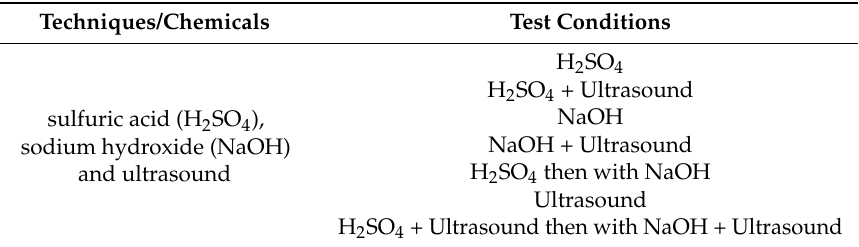
Table 2. Various experimental conditions